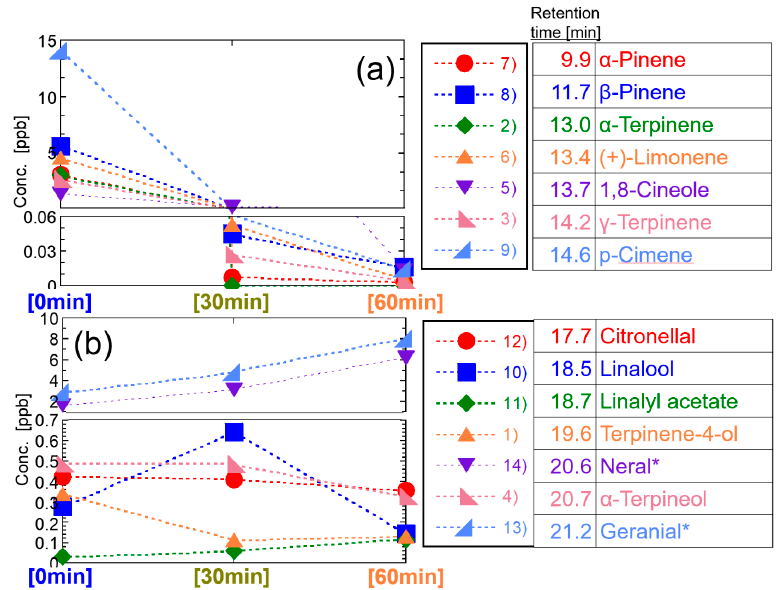
Figure 11. Summary of the temporal changes of 14 effective components diffused in the room air. ( a ) before, ( b ) after the retention time around 16 min. * Calculated by assuming the molar ratio of neral and geranial contained in citral is 1:1.